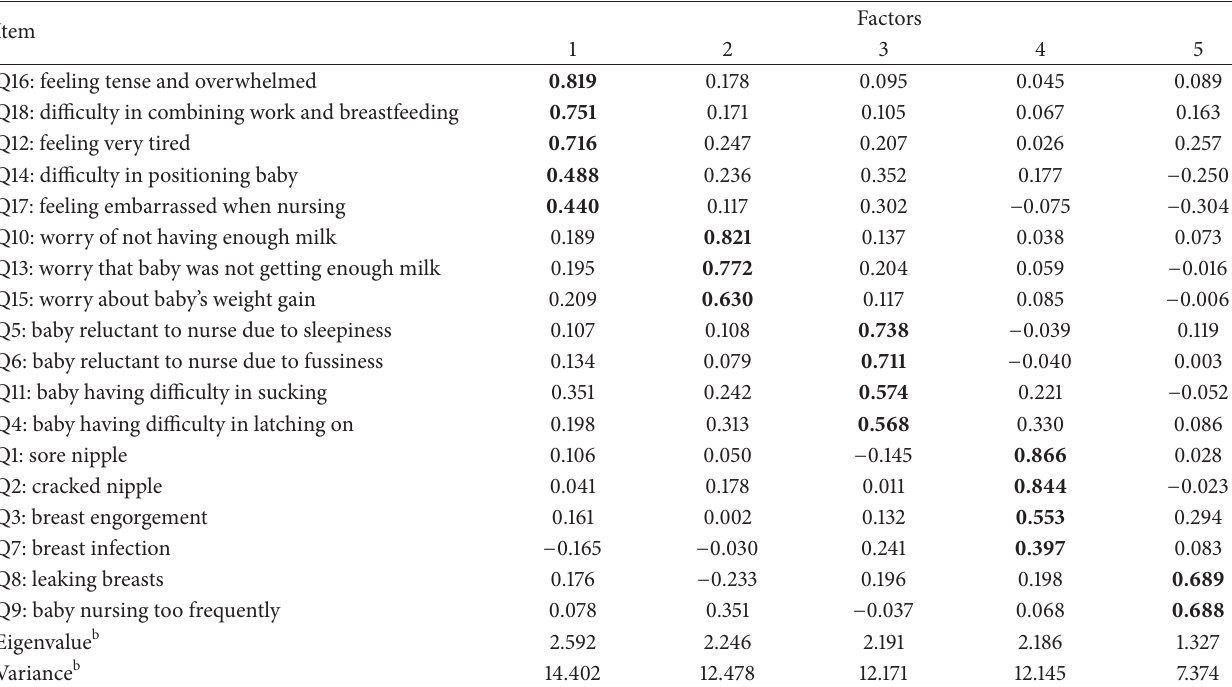
Table 1: Results of exploratory factor analysis (EFA).